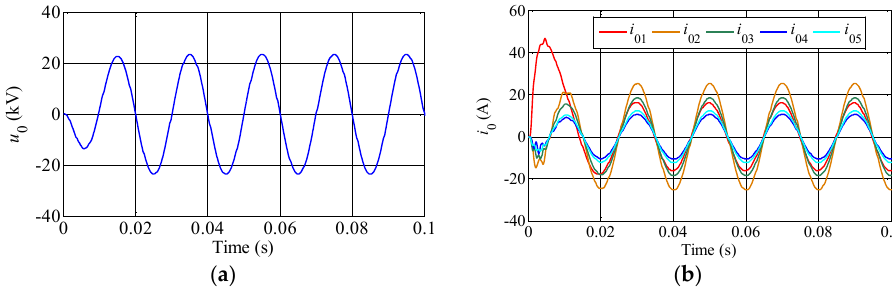
Figure 3. Bus zero-sequence voltage and zero-sequence current of each feeder for a single-phase HIF in K1 point. ( a ) Bus zero-sequence voltage; and ( b ) Feeders’ zero-sequence currents.